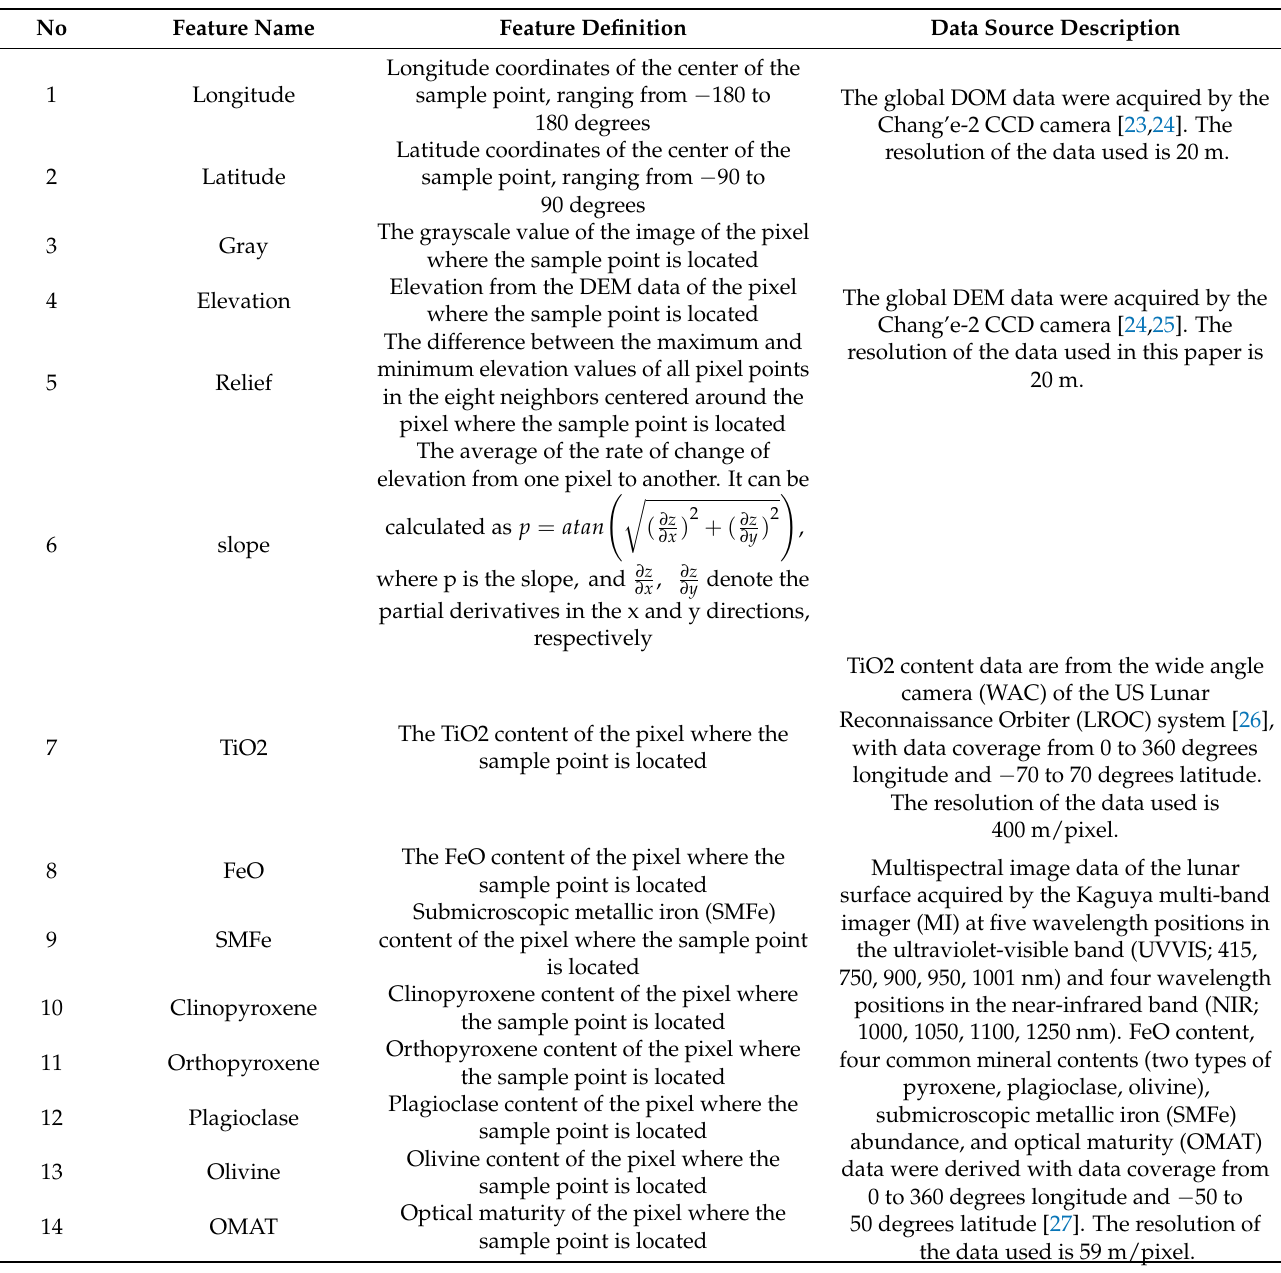
Table 1. Feature attributes of the sample data and their